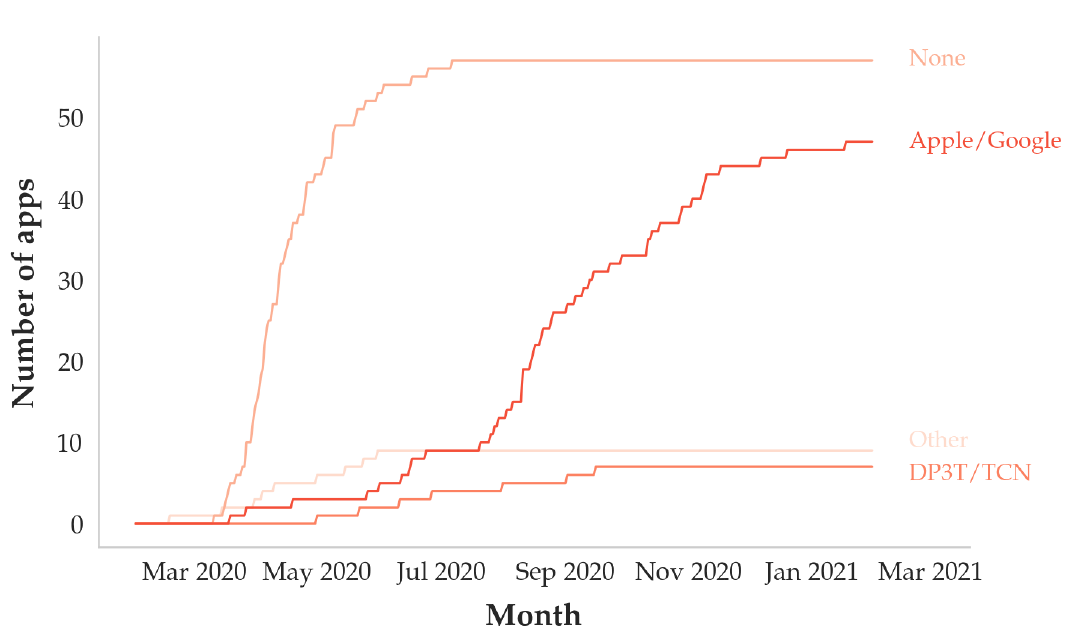
Figure 3. Cumulative number of contact tracing apps implementing different protocols. The major protocols include Apple/Google, and the closely related DP3T/TCN, both of which are decentralized protocols. Other protocols are combined into a single category for brevity, and include OpenTrace, SafePaths, ROBERT, PEPP-PT, ReCoVer, Whisper, and